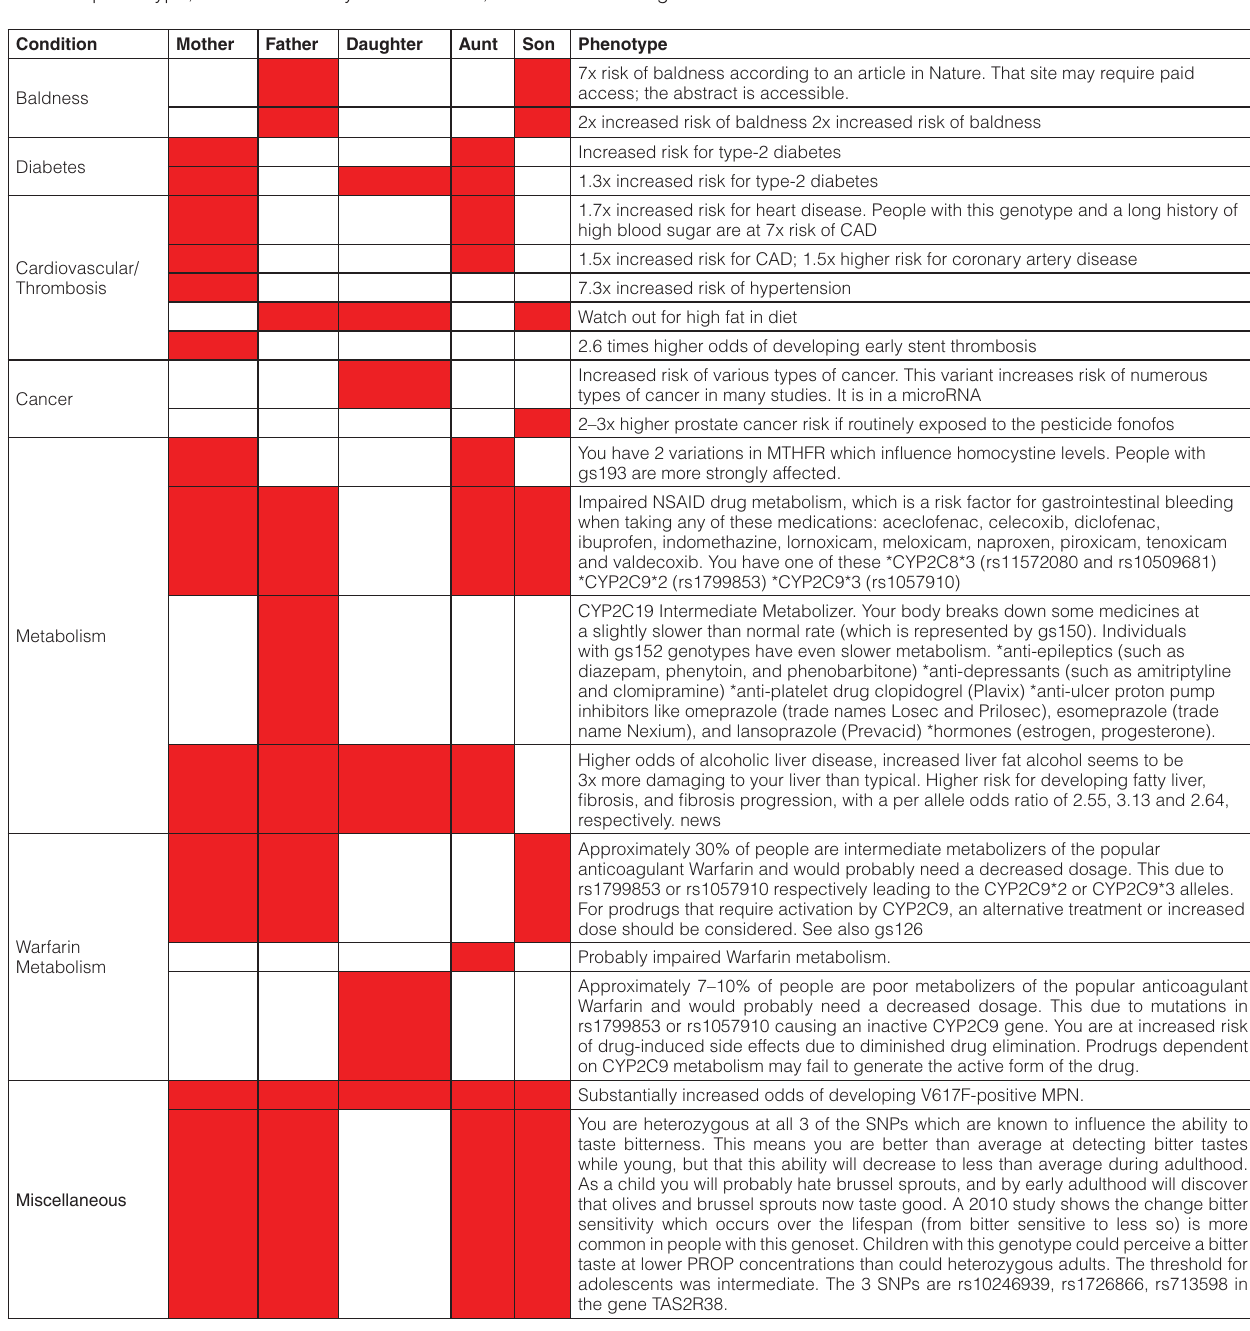
Table 7. A comparison of all SNPedia annotations with Magnitude >= 3 for all family members. Traits have been classified according to the general condition they relate. Red boxes are indicative of a particular phenotype being predicted in the individual. Descriptions for every matched phenotype, extracted directly from SNPedia, are shown in the right